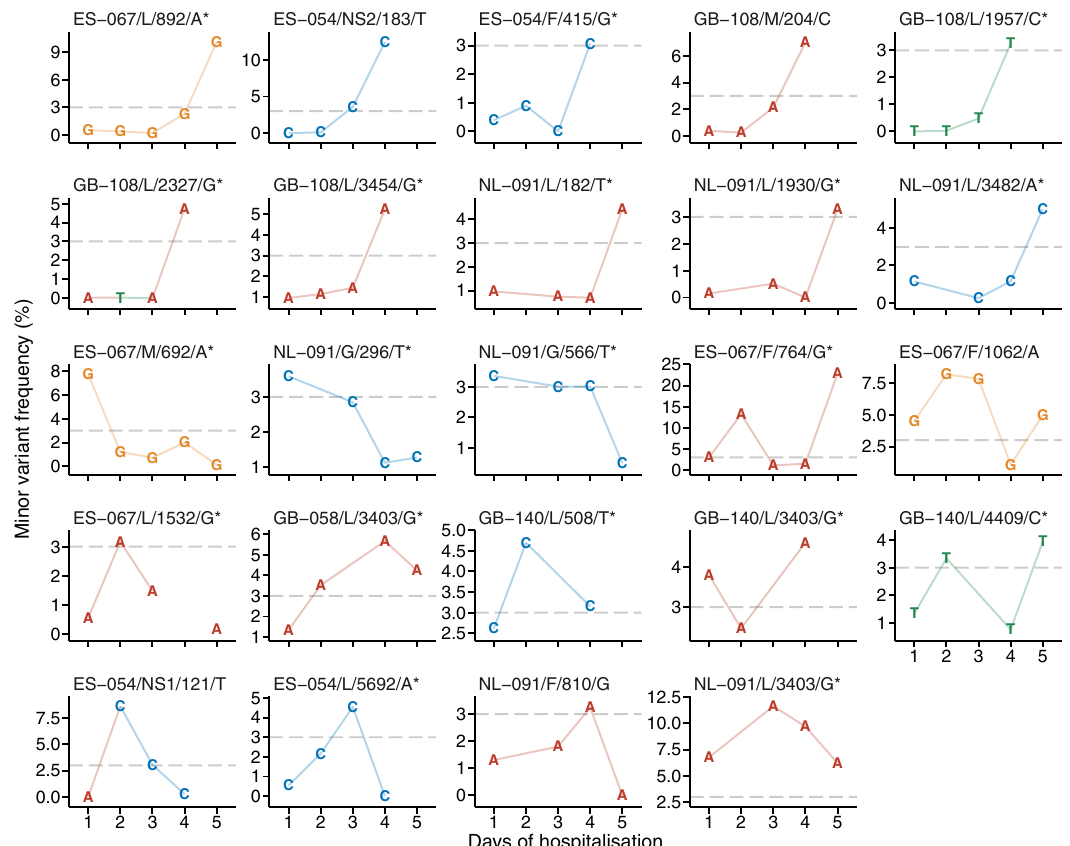
Fig. 4 Temporal change in minor alleles. Minor alleles and allele frequencies are shown at polymorphic sites within the coding sequence of the serial samples, where minor alleles were detected at ≥ 3 time points. The grey dashed lines represent the 3% threshold, which de fi nes a minor variant. Panels are labelled with the participant ID, followed by the gene name, the nucleotide position and the consensus base. Asterisks denote nonsynonymous substitutions. Letters in the plots denote minor allele bases. Panels are ordered by the trend of the change: increased, decreased and fl uctuated. Positions are numbered from the fi rst base of the coding sequence of each gene according to the NCBI reference sequences with the accession numbers of NC_038235 and NC_001781 for RSV-A and RSV-B,